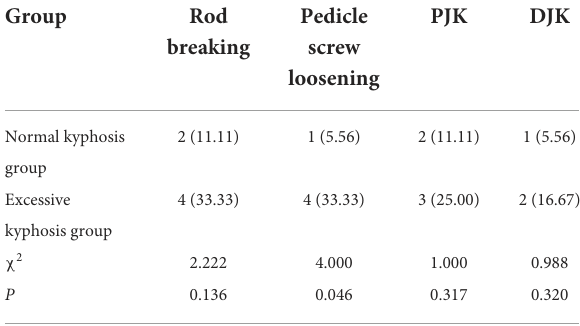
TABLE 4 Comparison of incidence of complications between the two groups [ n